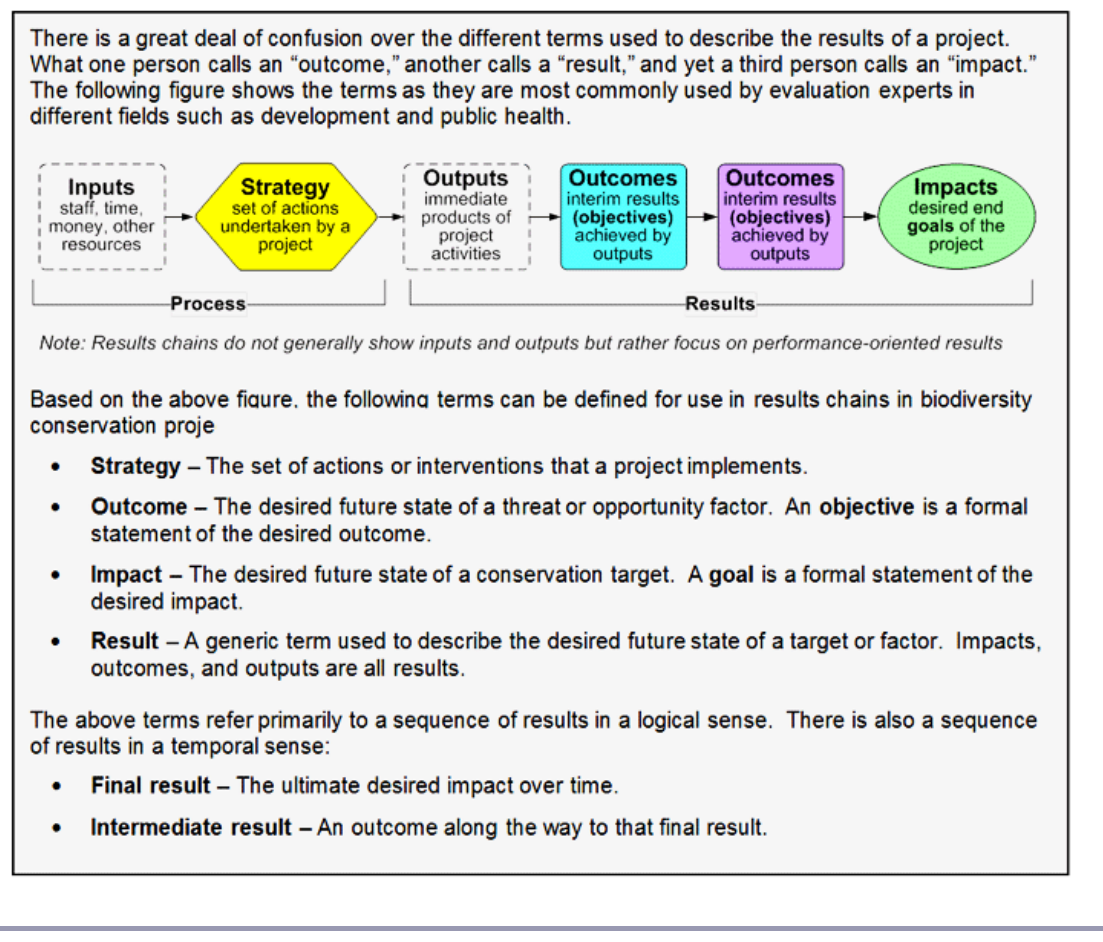
Fig. 1 . An overview of terms used to describe